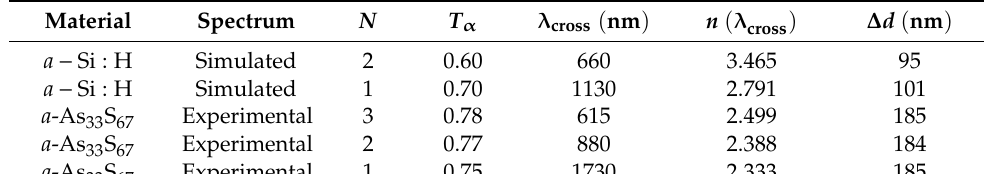
Table 1. Envelope-crossover points and direct alternate estimates for n and ∆ d , for the model-generated transmission spectrum belonging to the simulated a -Si:H film and plotted in Figure 4b, and to the real As 33 S 67 film S4 and plotted in Figure 5d, and also fully and accurately characterized, from the optical standpoint, in the GUI of the devised optical-characterization computer program.